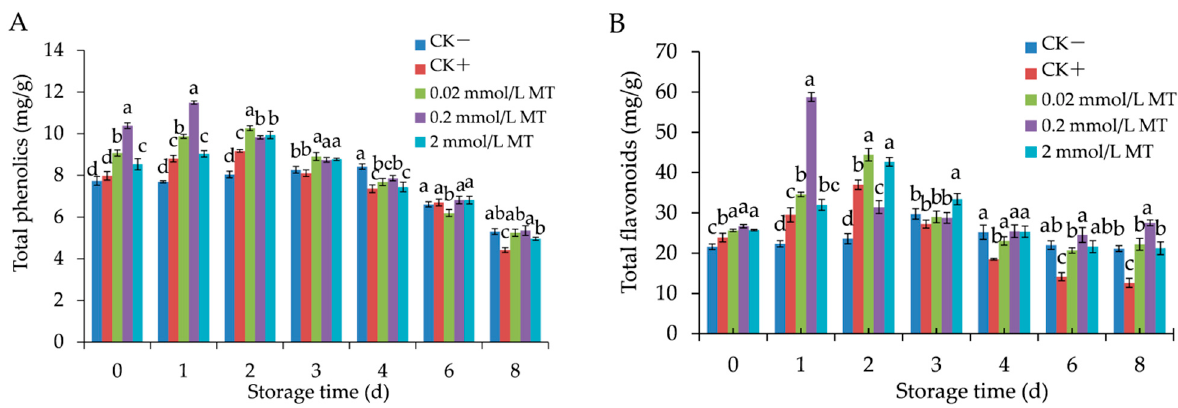
Figure 5. Effect of melatonin treatment on total phenolics ( A ) and flavonoids ( B ) in grape berries. Data represent means ± S.E. ( n = 3). Duncan’s multiple range test was used to analyse significant differences in data, and letters above the bars represent differences at p < 0.05.